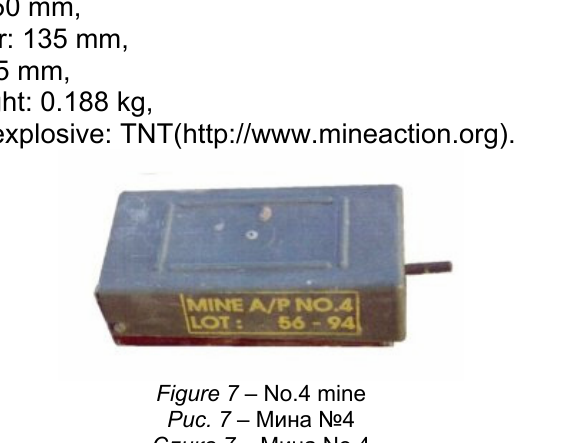
Figure 7 – No.4 mine Рис . 7 – Мина № 4 Слика 7 – Мина